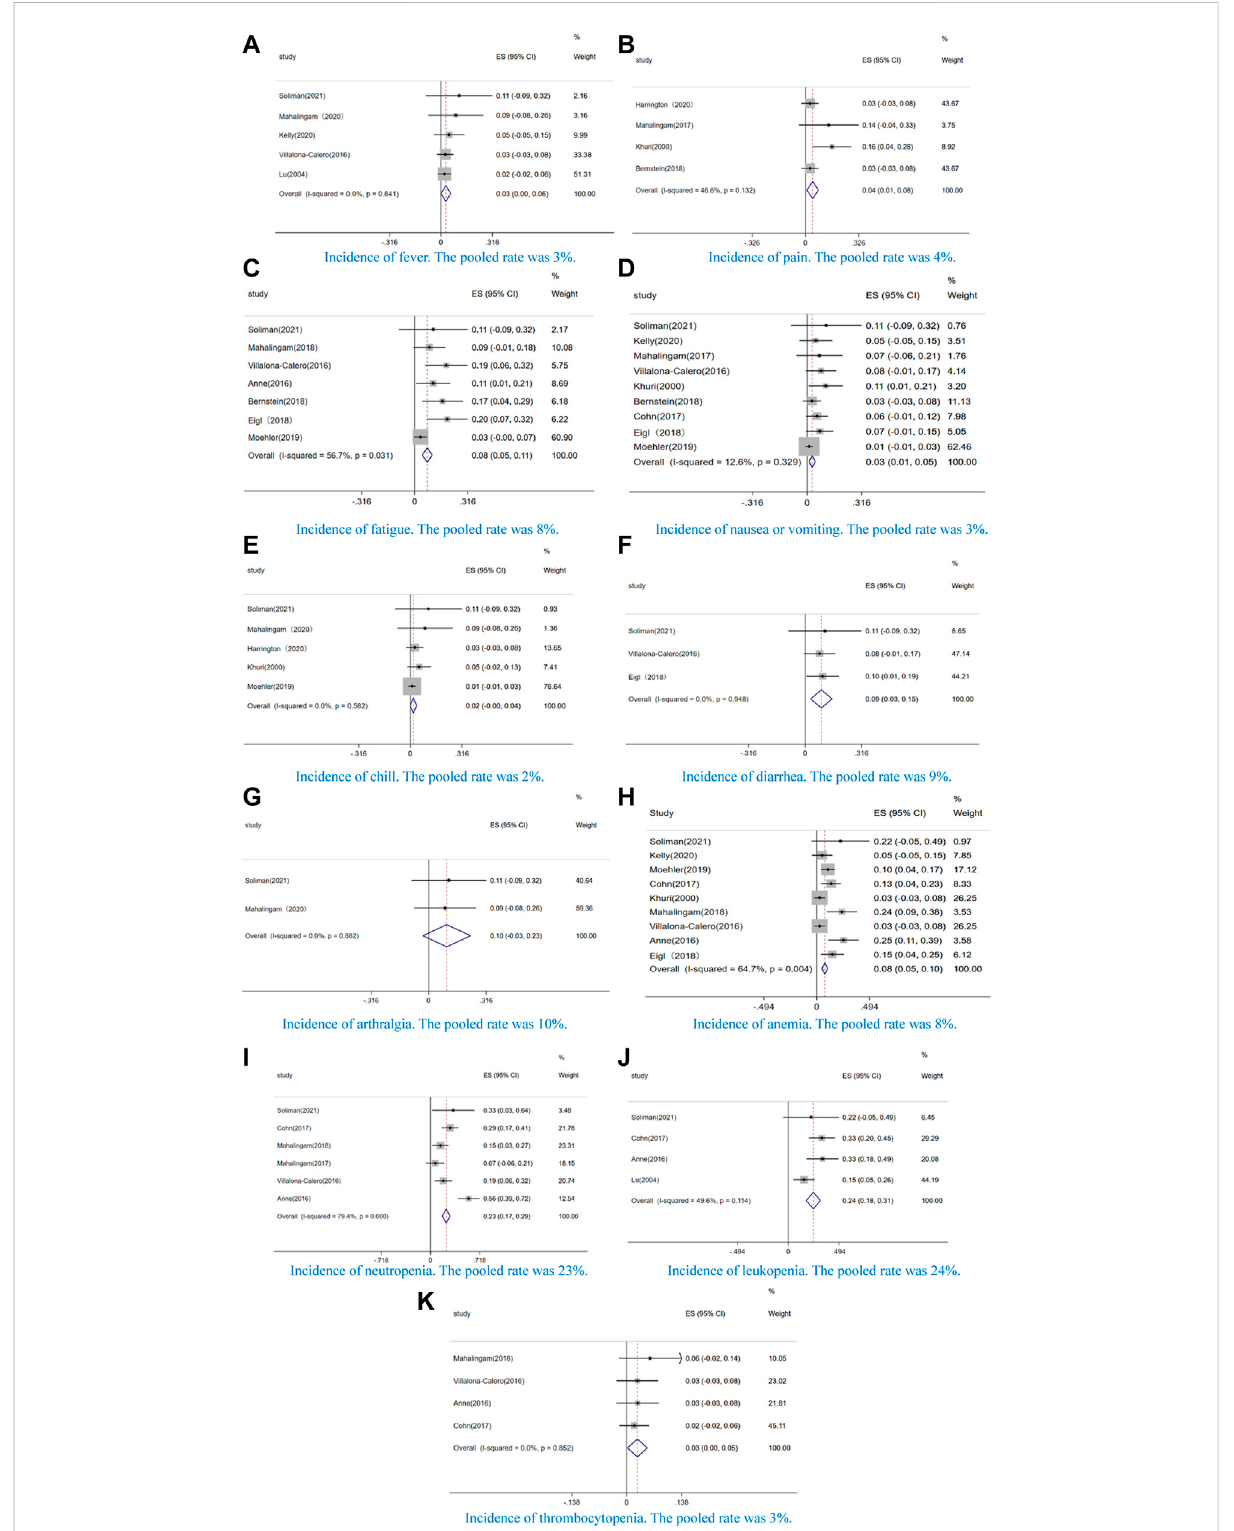
FIGURE 5 Forest plot of the pooled data that the incidence of incidence of grade 3 or greater AEs, including (A) fever, (B) pain, (C) fatigue, (D) nausea or vomiting, (E) chill, (F) diarrhea, (G) arthralgia, (H) anemia, (I) neutropenia, (J) leukopenia, and (K) thrombocytopenia.